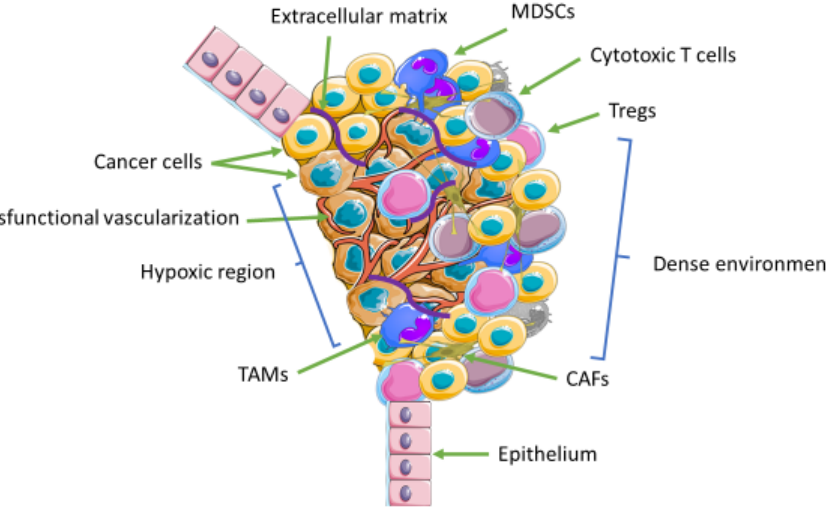
Figure 2. The tumor microenvironment consists of noncancerous cellular and noncellular components. There is a cross talk between cancer cells and the components of the tumor microenvironment, which cancer cells use to their advantage and create a suitable environment for cancer progression and survival. Amongst these is the recruitment of immunosuppressive cells, which dampens anticancer immune response and facilitates cancer growth and drug resistance. The dense regions of the tumor microenvironment prevent penetration of drugs into the core of the tumor. Blood vessels become cramped and dysfunctional resulting in a lack of blood supply and hypoxic conditions. Cancer cells use mechanisms that allow them to adapt and survive.